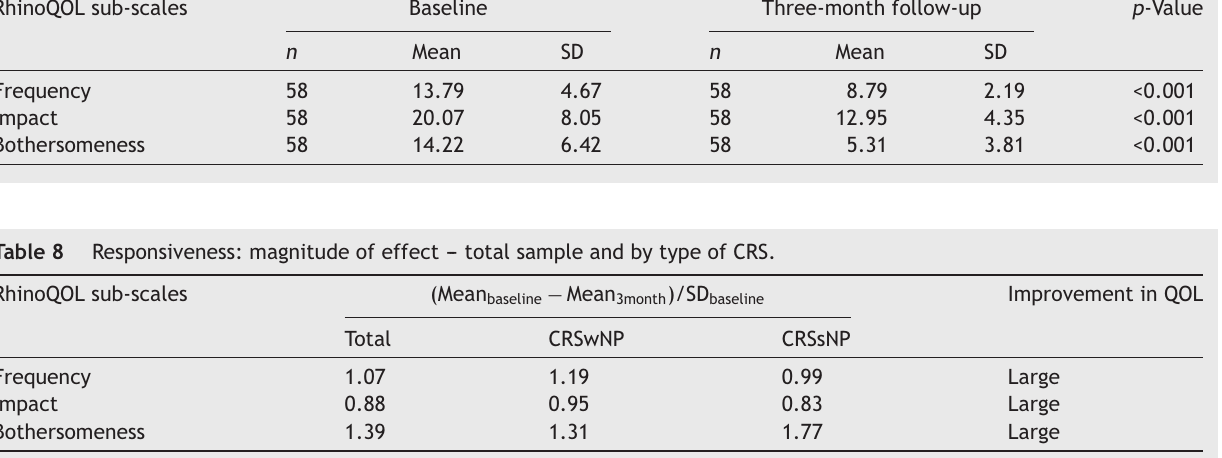
Responsiveness: scores at baseline and at three-month postoperative follow-up ( ˛ = 0.05). RhinoQOL sub-scales